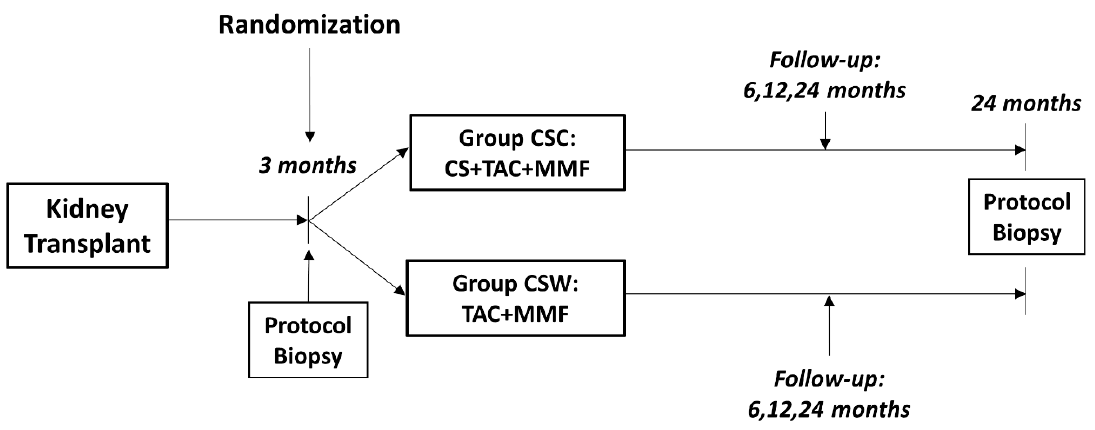
Figure 1. Study design timeline.